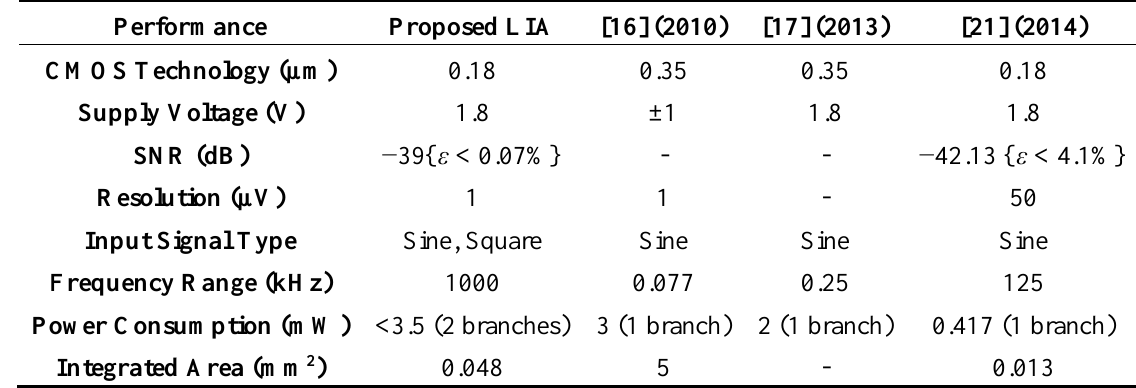
Table 4. Performance comparison of integrated LIA-based